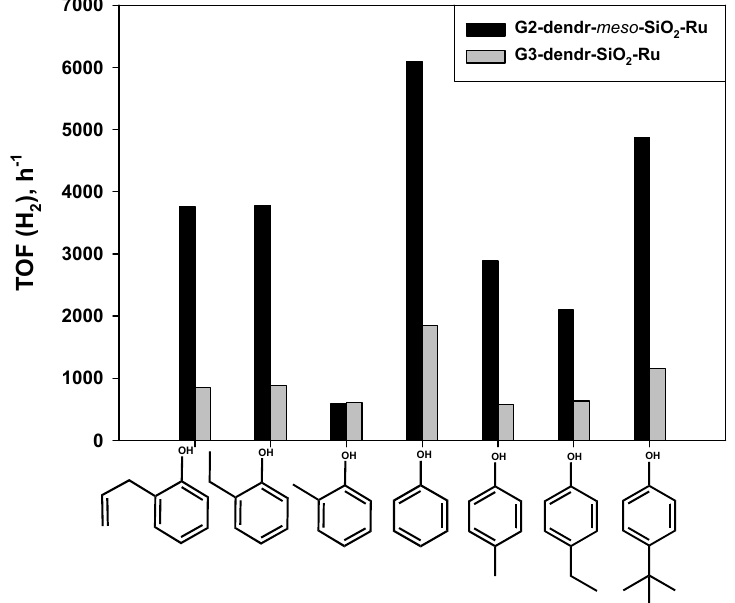
Figure 9. Hydrogenation of alkyl-substituted phenols in the presence of porous silica-immobilized dendrimer-based Ru catalysts. Reaction conditions are: at 80 °C, 3 MPa of H 2 , V (substrate) = V (H 2 O). Table 4. Activities comparison for G1–HMDI–Ru [57] and G2-dendr- meso -SiO 2 -Ru in the hydrogenation of alkyl-substituted phenols 1 .